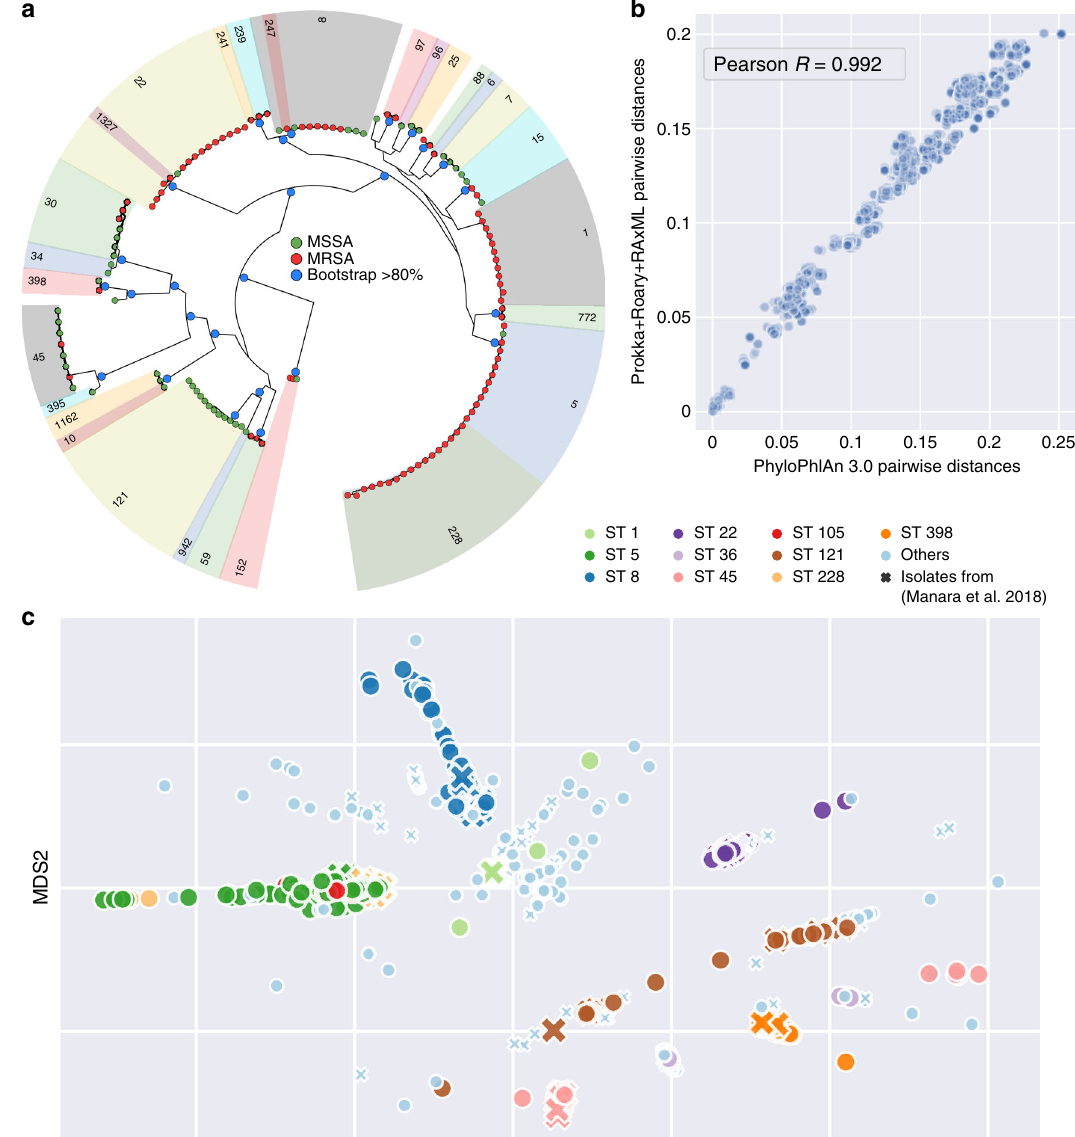
Fig. 2 Accurate reconstruction of Staphylococcus aureus phylogenies using PhyloPhlAn 3.0. a Phylogenetic tree of 135 S. aureus strains from a pediatric hospital 36 reconstructed by PhyloPhlAn 3.0 using 2127 automatically identi fi ed core genes (rendered by GraPhlAn 39 see Supplementary Fig. 2 for a full comparison). Green circles represent the methicillin-sensitive S. aureus (MSSA), while red circles represent methicillin-resistant S. aureus (MRSA). Blue circles internal to the phylogeny identify subtrees with bootstrap >80%. b Normalized phylogenetic distances in the PhyloPhlAn 3.0-reconstructed tree and in a manually curated phylogeny from ref. 36 highlighting strong consistency between the automated PhyloPhlAn 3.0 results and the curated tree (0.992 Pearson ʼ s correlation coef fi cient). c Multidimensional scaling ordination of pairwise phylogenetic distances from the tree integrating the 135 S. aureus isolates (crosses) with 1000 automatically selected S. aureus reference genomes (circles, Supplementary Fig. 1). The ten most prevalent sequence types (STs) 23 are highlighted in different